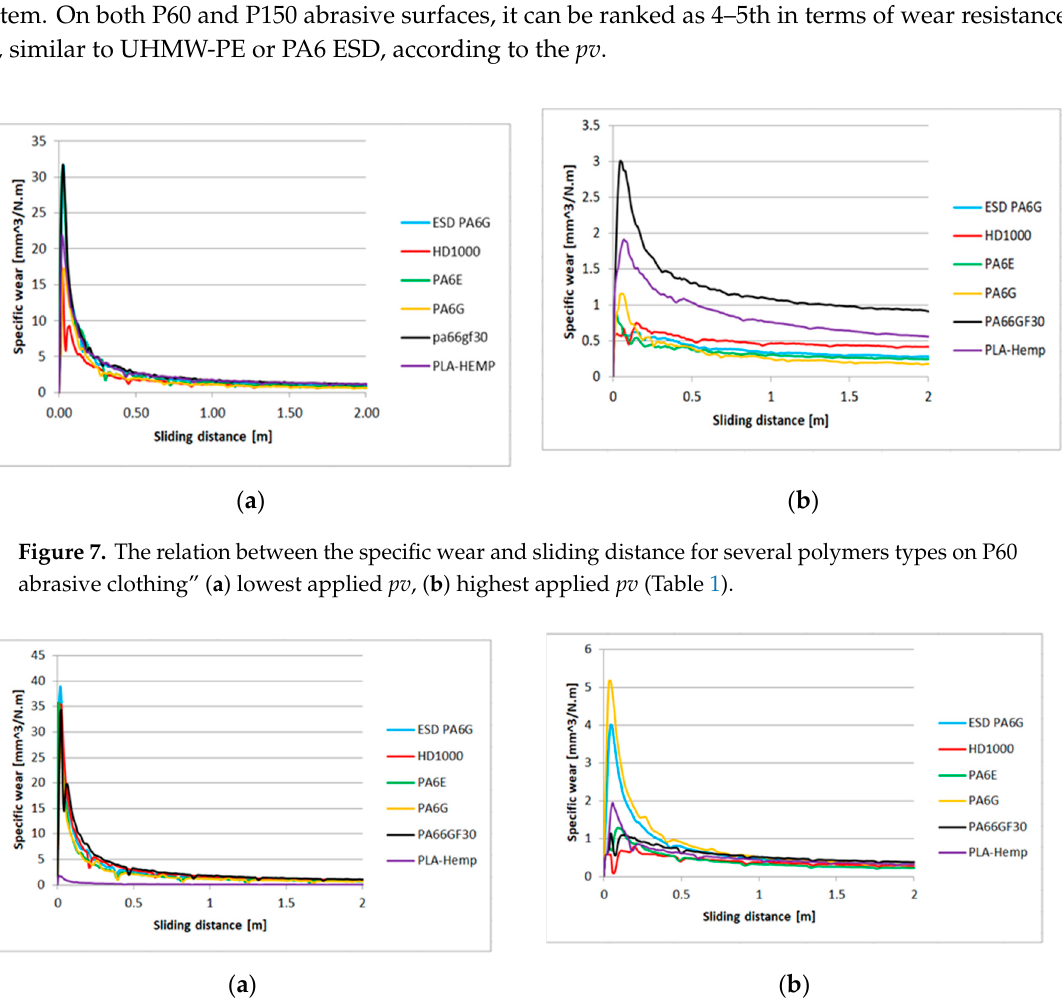
Figure 8. The relation between the specific wear and sliding distance for several polymers types on P150 abrasive clothing: ( a ) lowest applied pv , ( b ) highest applied pv.